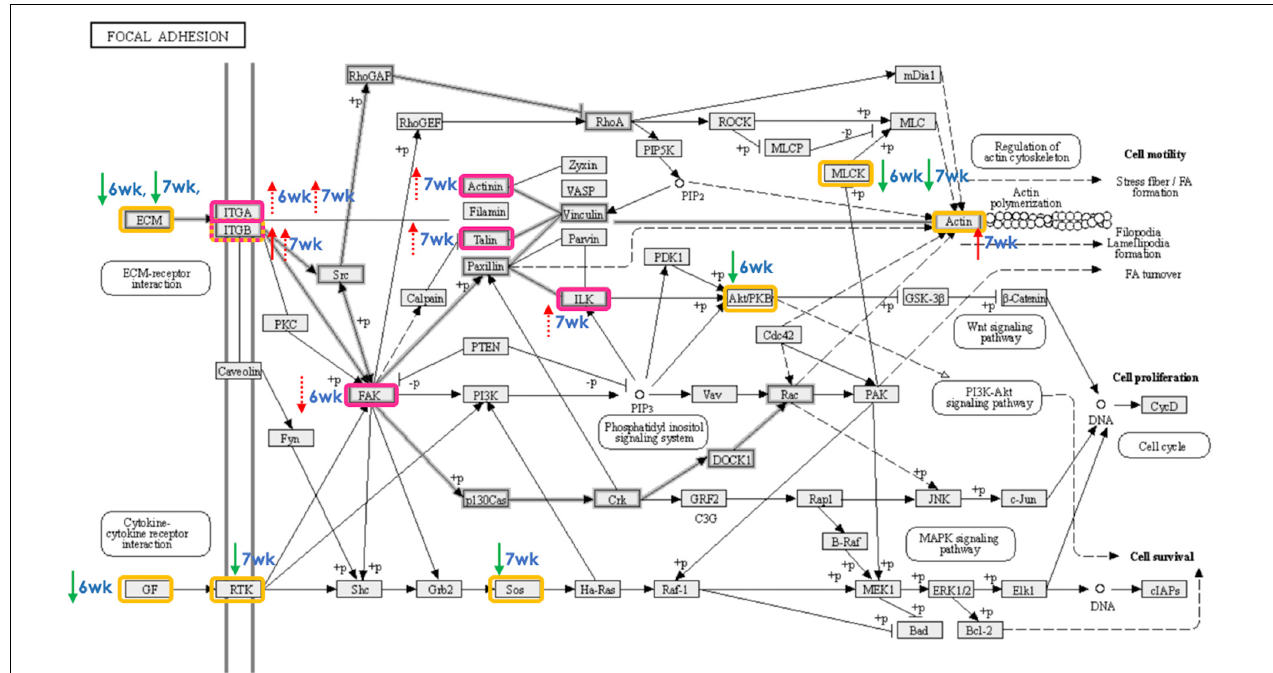
FIGURE 5 | Focal adhesion signaling pathway as affected by development of wooden breast (WB) in 6-week-old and 7-week-old broilers. The proteins highlighted in yellow and pink boxes exhibited differential expression, as detected using microarray and droplet digital polymerase chain reaction, respectively, in skeletal muscle of broilers affected WB myopathy in comparison with their non-defective counterparts. The red and green arrows (solid = microarray, dashed = ddPCR) indicate the increased and decreased expression, respectively, of the gene-encoded protein in WB relative to non-WB of 6-week-old (6wk) or 7-week-old (7wk) broilers.